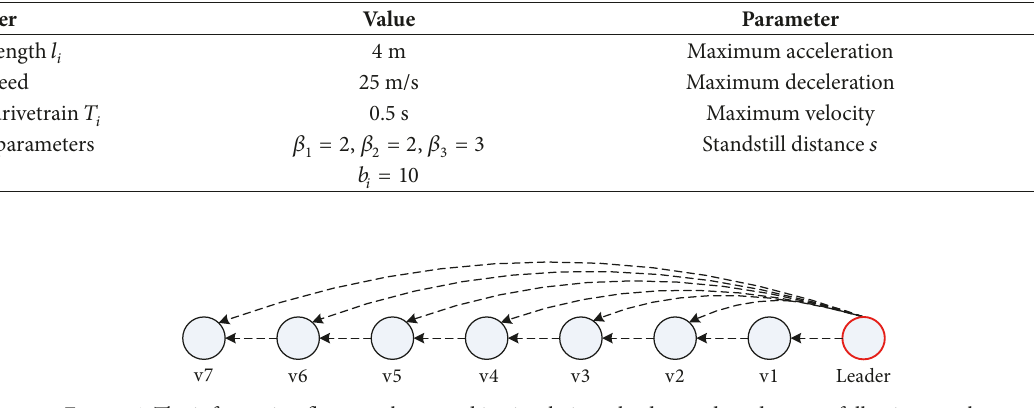
Figure 1: The information flow topology used in simulations: leader- and predecessor-following topology.